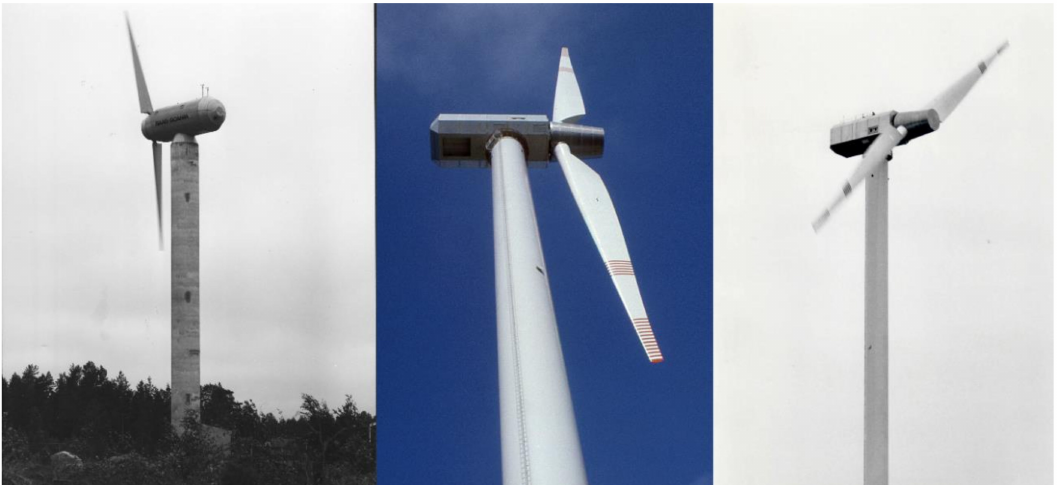
Figure 1. The Kalkugnen and Maglarp turbines. Left: The 60-kW Kalkugnen turbine at Älvkarleby. Photo used with permission from SAAB. Center and right: The 3-MW WTS-3 turbine at Maglarp. Photo used with permission from Jos Beurskens (center, all rights reserved) and Sydkraft/E.ON